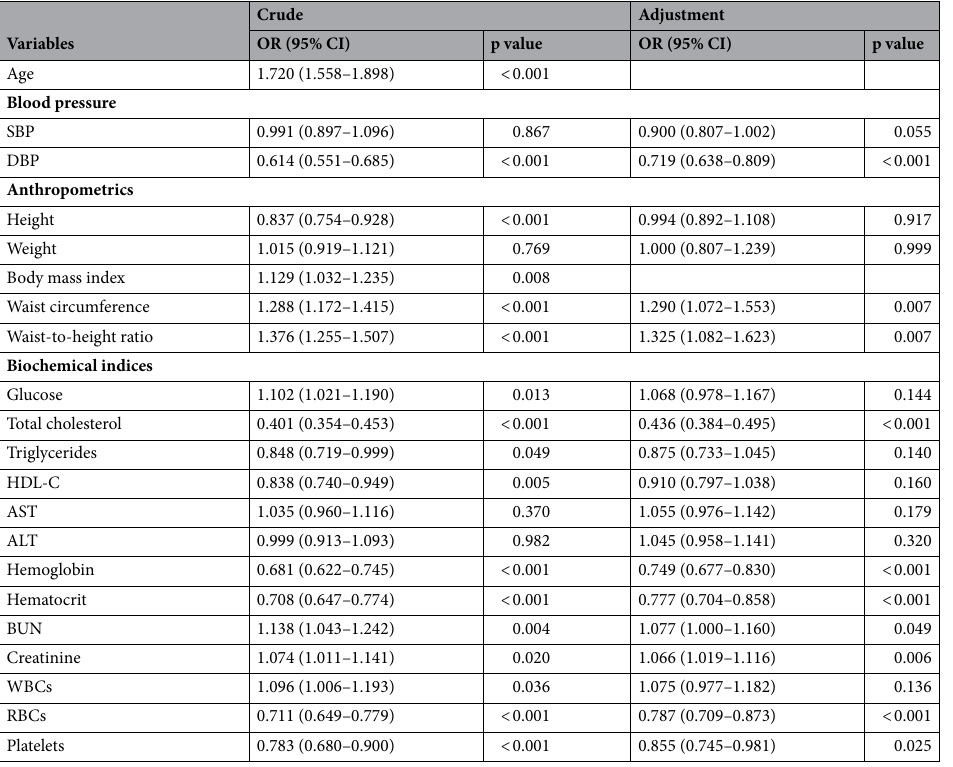
Table 2. Associations of MIAP with blood pressure, anthropometric indices, and biochemical indices in men . OR and p values were obtained from the crude and adjusted analyses using complex sample binary logistic regression. Age, residential area, education, occupation, household income, stress, alcohol consumption, smoking status, family history of IHD, and BMI were used as adjustment variables. Odds ratios were estimated with 95% confidence intervals. MIAP myocardial infarction or angina pectoris, IHD ischemic heart disease, SBP systolic blood pressure, DBP diastolic blood pressure, HDL-C high-density lipoprotein cholesterol, AST aspartate aminotransferase, ALT alanine aminotransferase, BUN blood urea nitrogen, WBC white blood cell, RBC red blood cell, OR odds